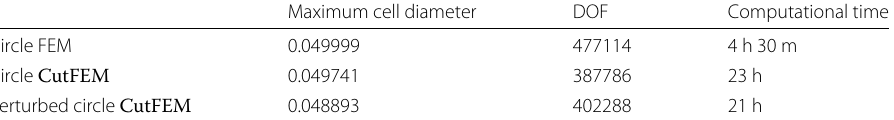
Table 1 In the table shows the maximum cell diameter, the number of DOFs, and the computational time for FEM and CutFEM in a circular domain and for CutFEM for the perturbed boundary